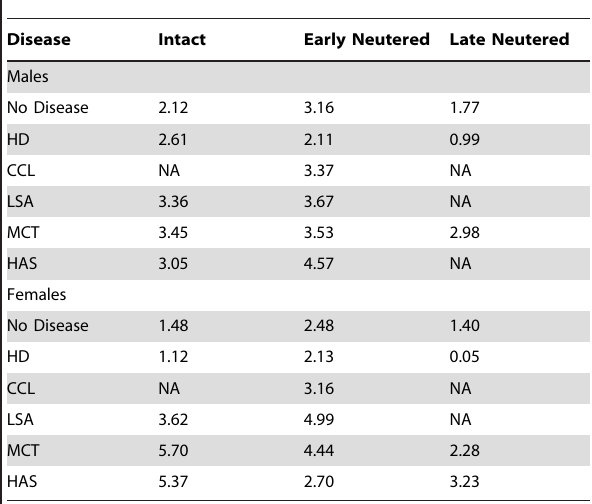
Table 2. Total sample sizes obtained for male and female Golden Retrievers (1–8 years old) admitted to the Veterinary Medical Hospital, University of California, Davis, from 2000– 2009 according to neuter status classification: intact, early- neutered, and late-neutered.